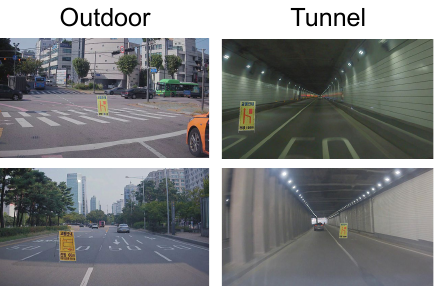
Figure 9. An example of synthesized training set in outdoor and tunnel